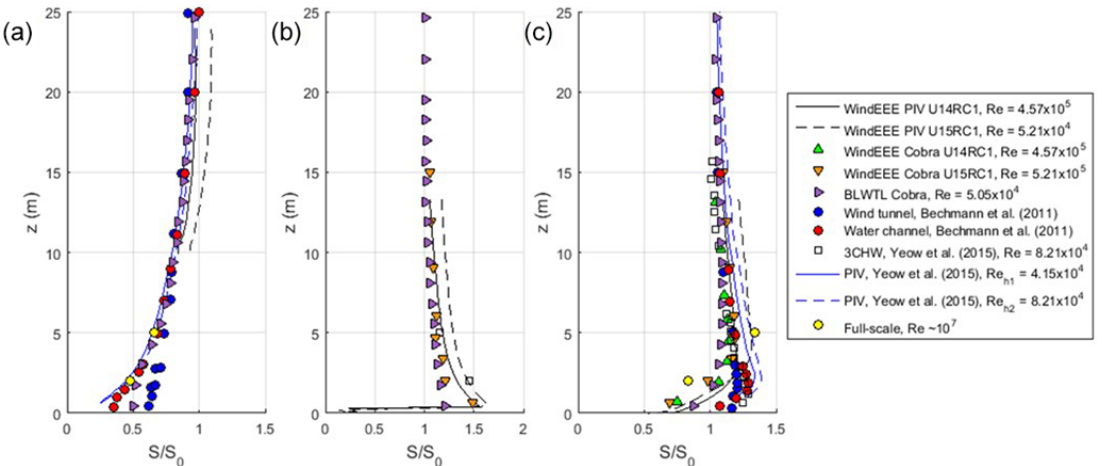
Figure 10. Vertical profiles of speed-up ratio for WindEEE and BLWTL cases at (a) M7 ( X =− 66.9m), (b) escarpment ( X =− 54.7m), and (c) M6 ( X =− 46.1m). Results from full scale and other previous physical experiments presented for